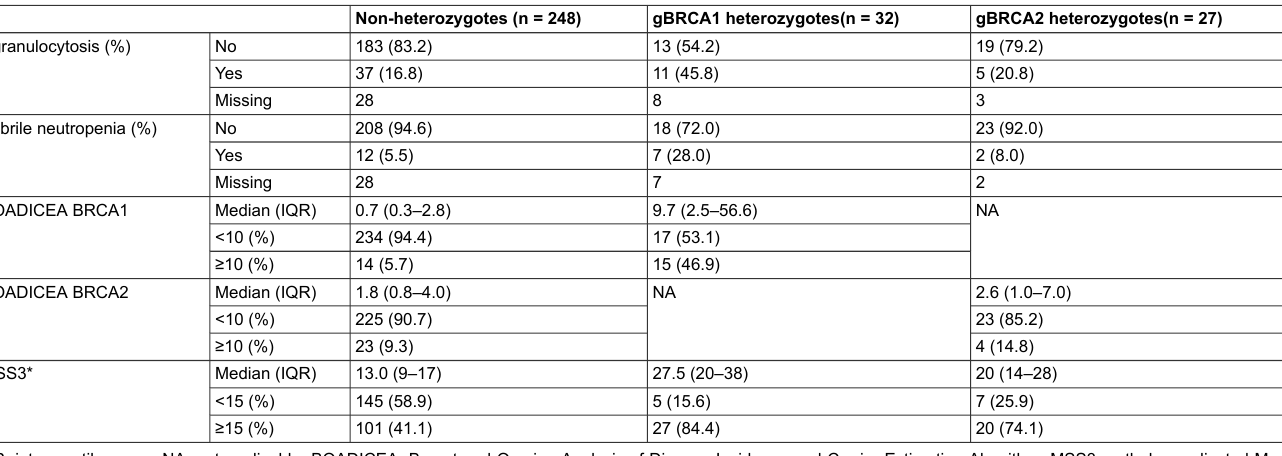
Table 2: Haematological toxicity during C1; MSS3 and BOADICEA scores per mutational status. Agranulocytosis (%)